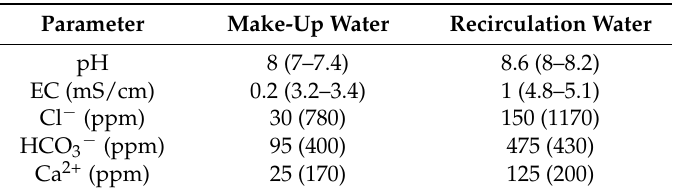
Table 1. Desired features for make-up and recirculation water in HSM; in brackets not treated water values are